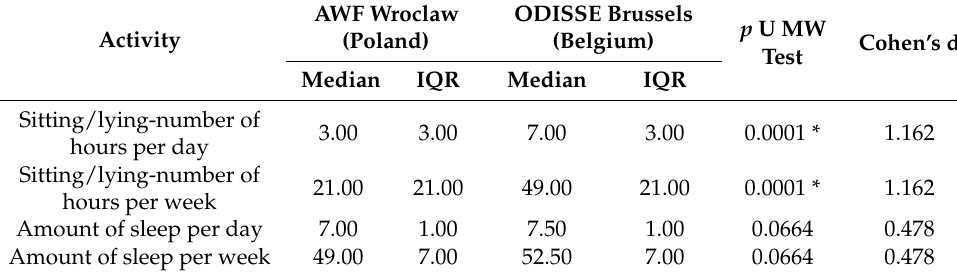
Table 9. Daily and weekly sleep time and time spent sitting and lying down (GPAQ).